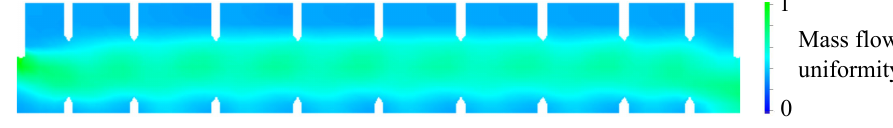
Figure 8. Uniform particle mass flow along the HEX, averaged over 200